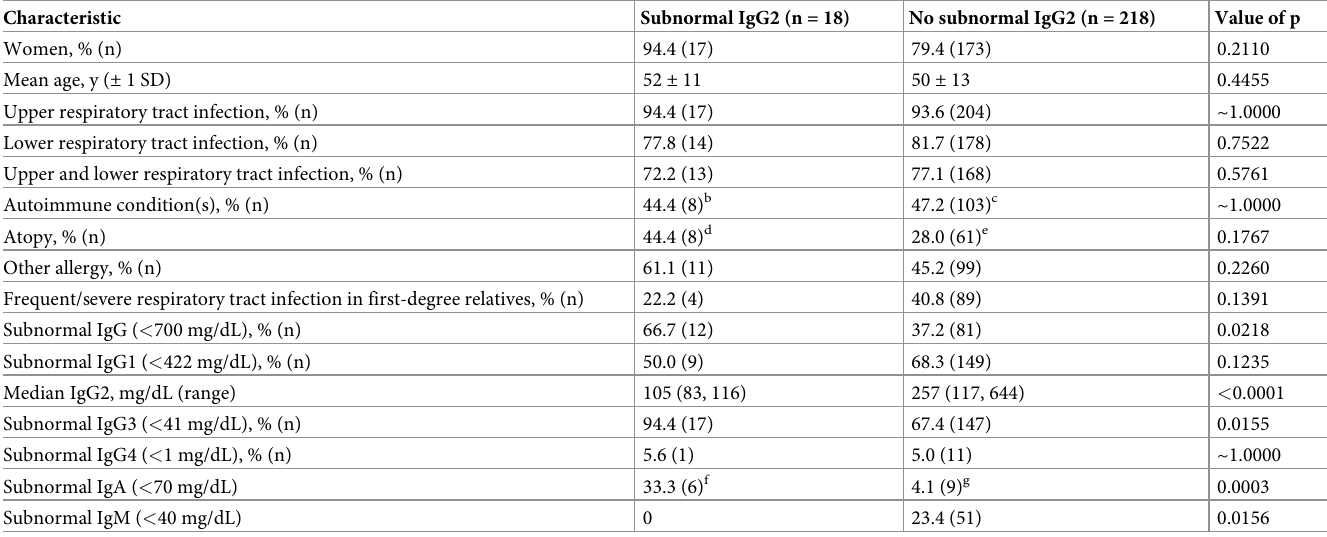
a Abbreviations: IgGSD, immunoglobulin G subclass deficiency; IgG1, immunoglobulin G1; IgG2, immunoglobulin G2; IgG3, immunoglobulin G3; IgG4, immunoglobulin G4; SD, standard deviation. No patient had monoclonal gammopathy detected by serum electrophoresis and immunofixation.